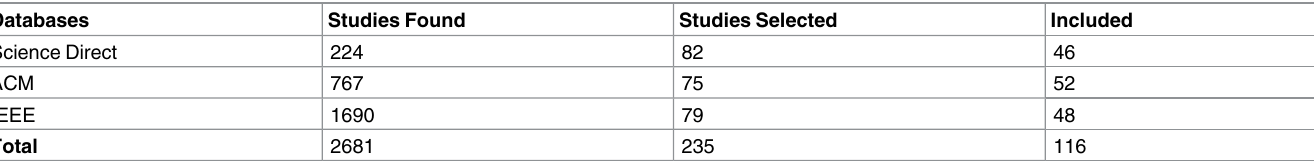
Table 4. Studies found and included in the mapping